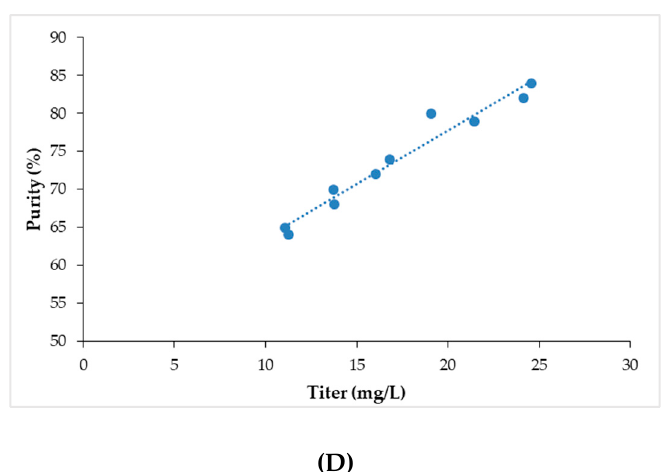
Figure 6. The results of the design of experiment (DOE) study showing ( A ) the actual vs. predicted plot for Fab production; ( B ) the estimates of the interactions amongst the sorted parameters, *P < 0.05; ( C ) the prediction profiles for Fab production; ( D ) the comparison of Fab titer vs. purity.